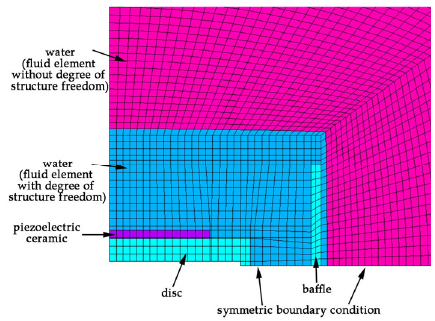
Figure 3. Finite element